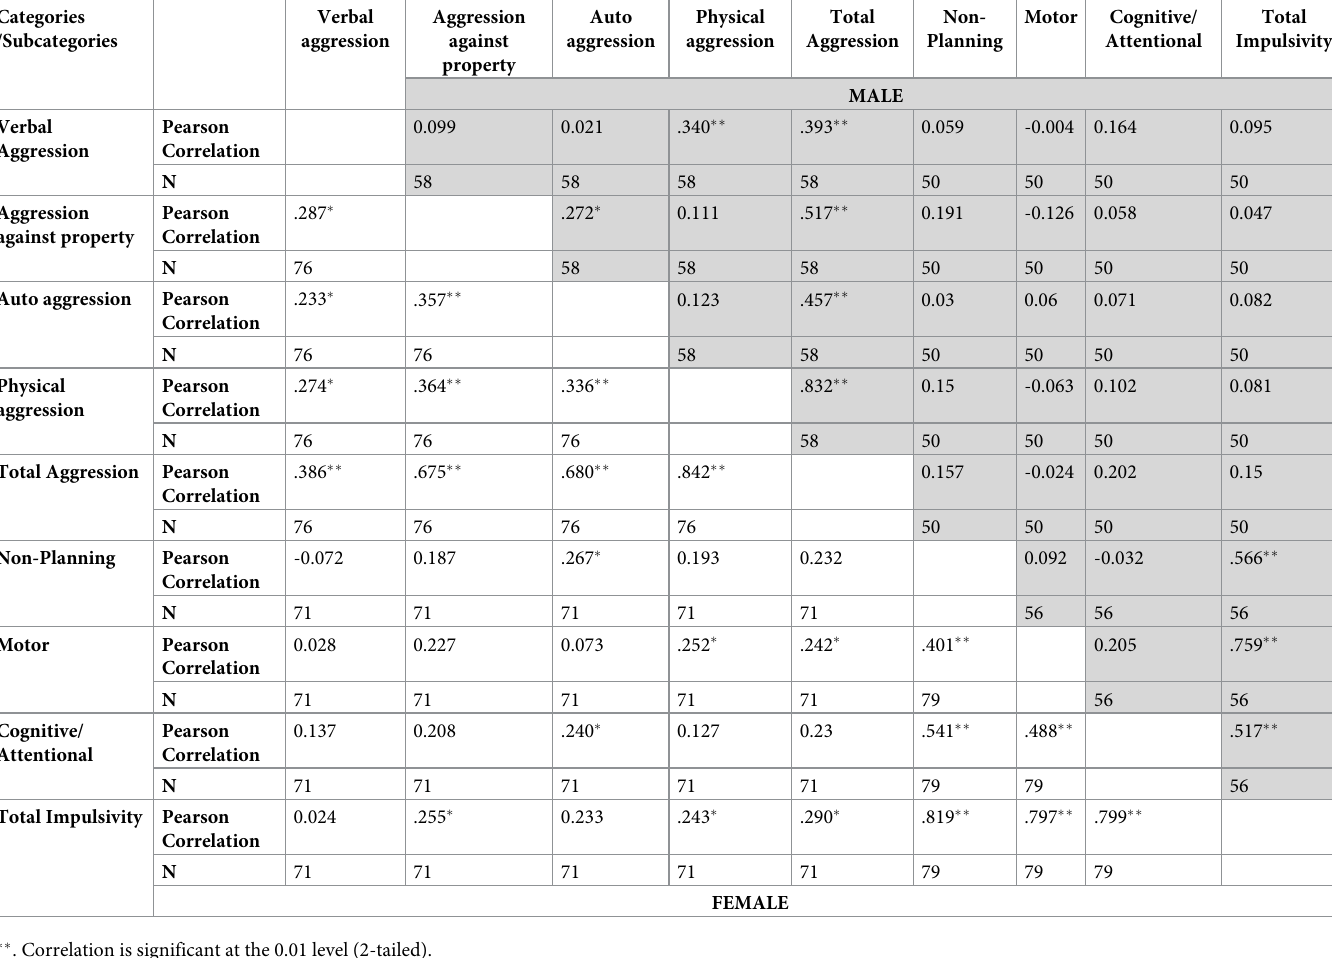
Table 3. Inter- correlations among traits of aggression and impulsivity in males and females of Idu Mishmi suicide attempters (Univariate Pearson correlation analysis). Categories /Subcategories